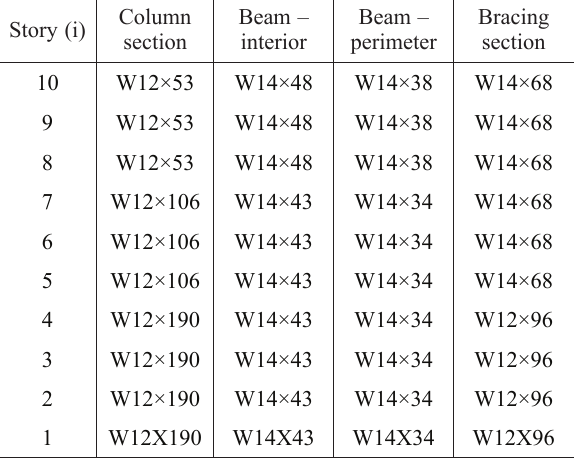
Table 2. Member data for horizontally irregular – Concentrically Braced Frame (CBF) (Young, Adeli 2014a,